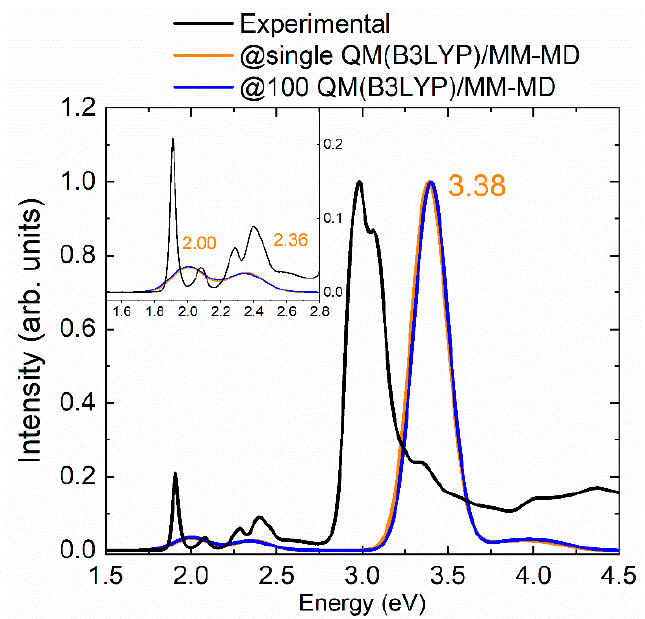
Figure 4. Comparison against the experimental reference (black) of the absorption spectra of mTHPC in methanol scaled with respect to the Soret band and computed from geometries obtained from @single-QM(B3LYP)/MM-MD simulation (orange) and from @100-QM(B3LYP)/MM-MD simulations (blue). The inset zooms the Q’ and Q’’ bands.